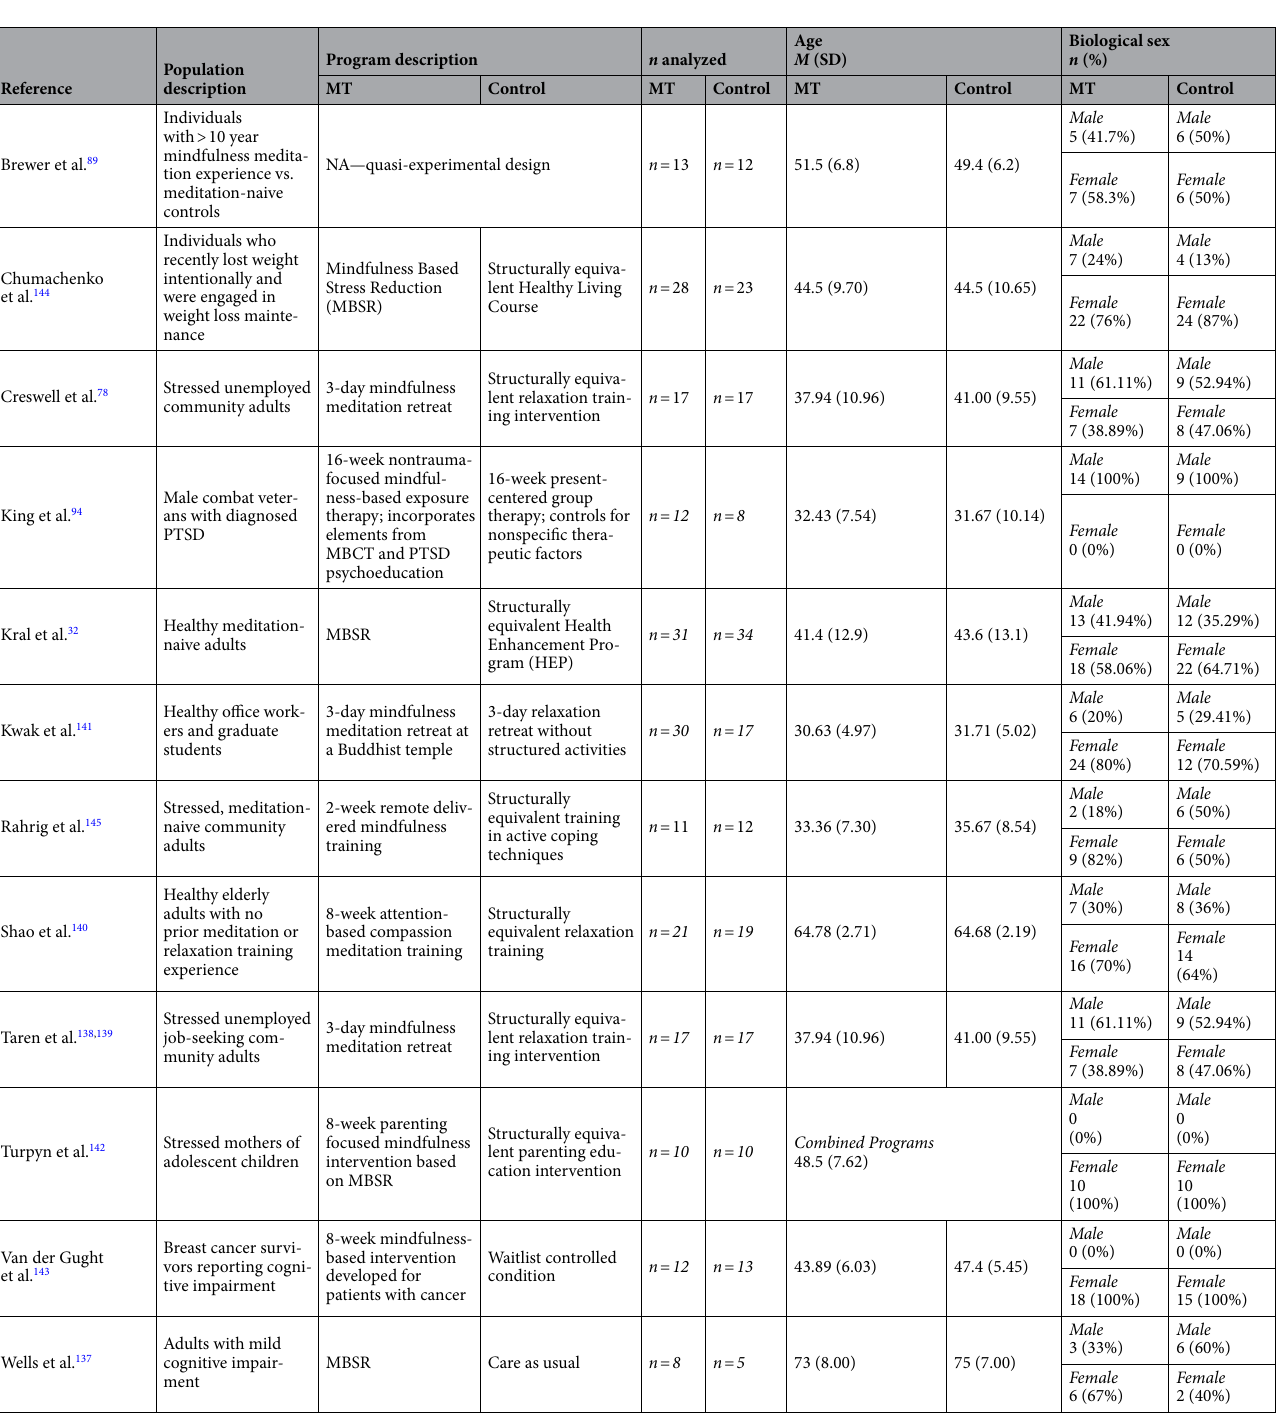
Table 1. Demographic characteristics of mindfulness and control